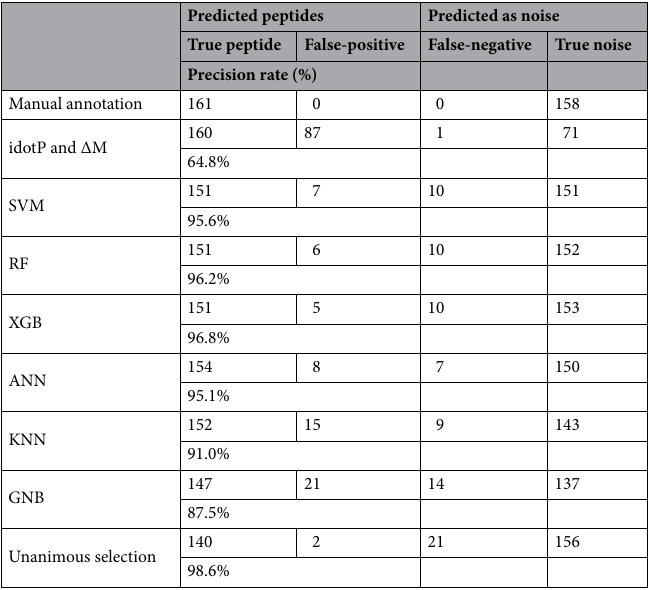
Table 1. Confusion matrices used in this study. Precision rate was defined as the number of true peptides divided by the number of peptides predicted as